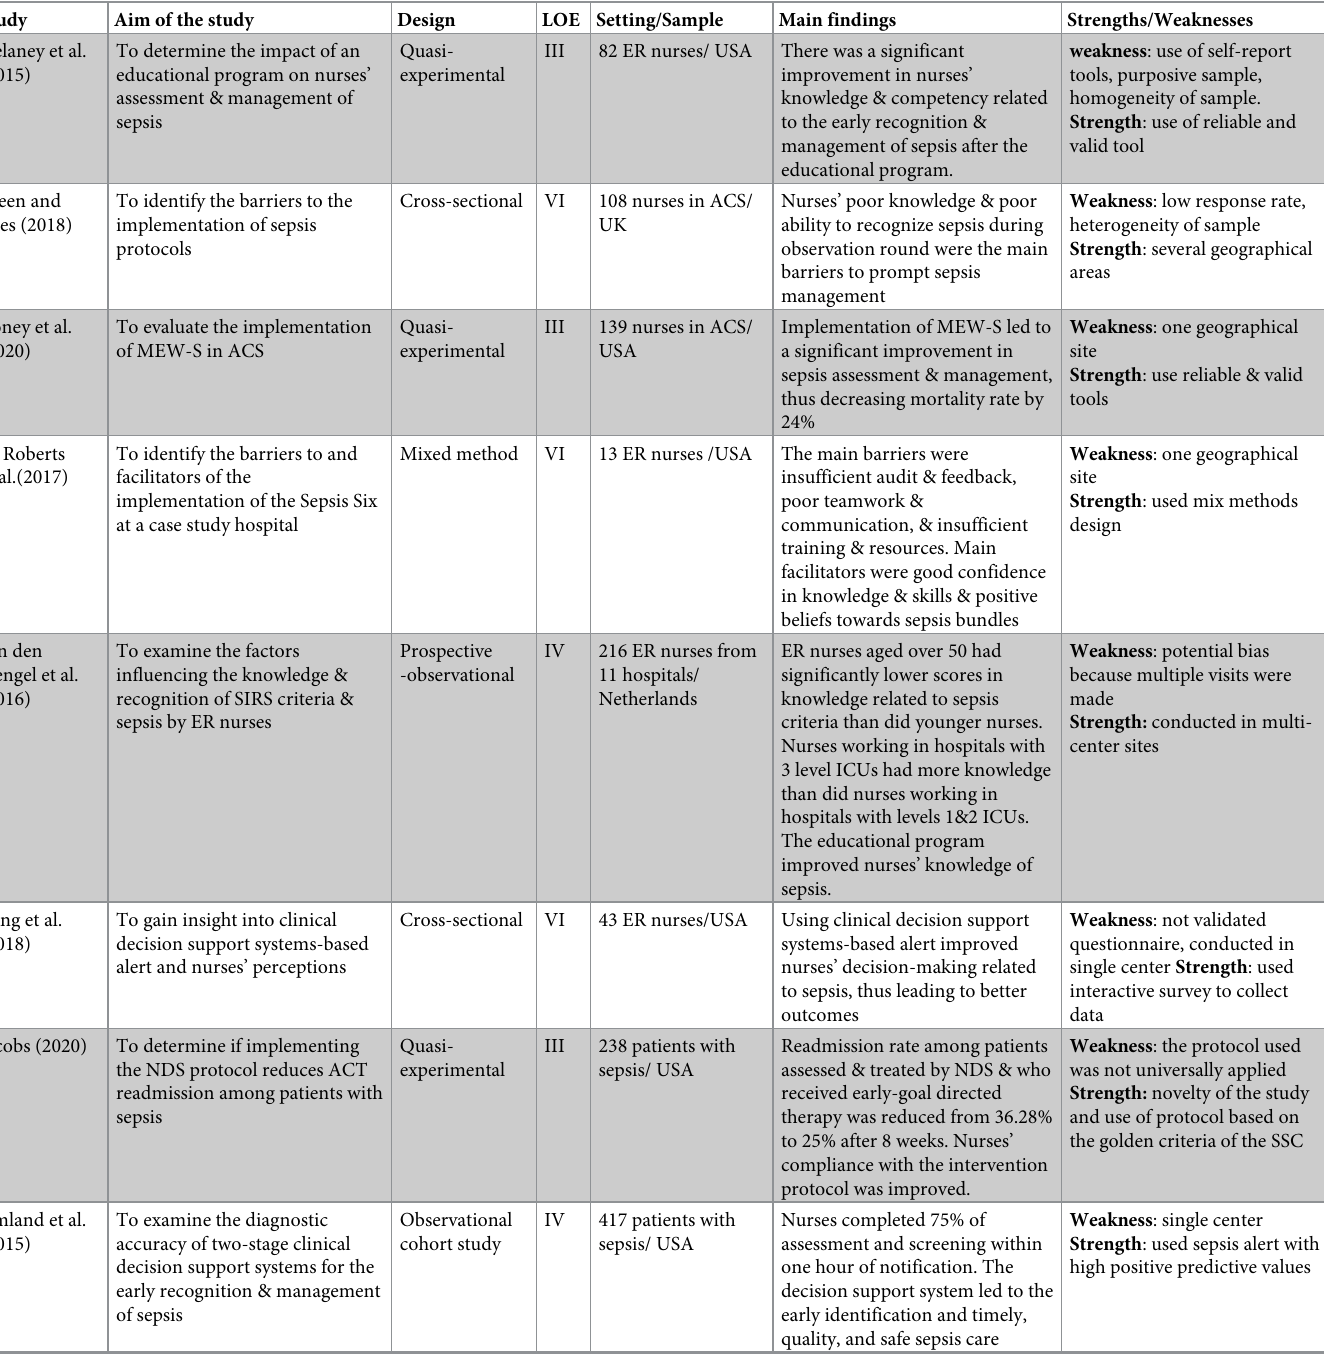
Table 2. Summary of the reviewed